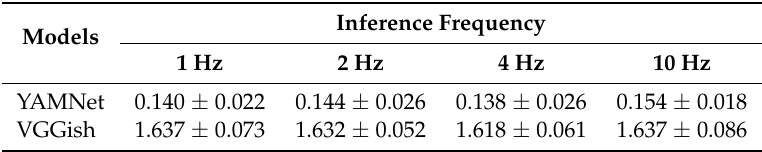
Table 4. YAMNet and VGGish inference times (mean ± standard deviation) (s) for four inference